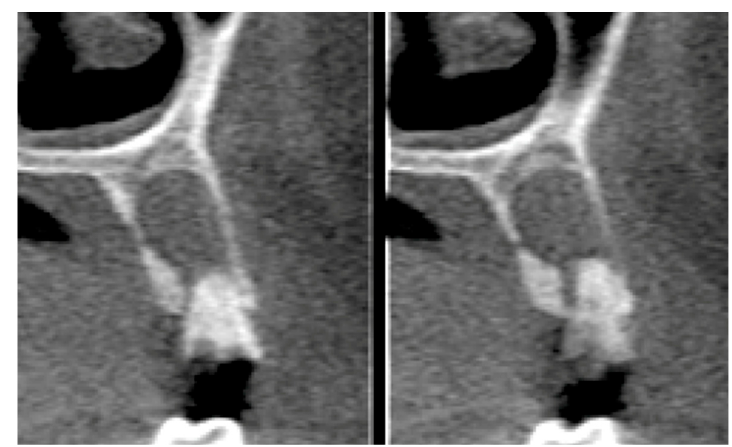
Figure 11. CT images of tooth 24 prior to the procedure.